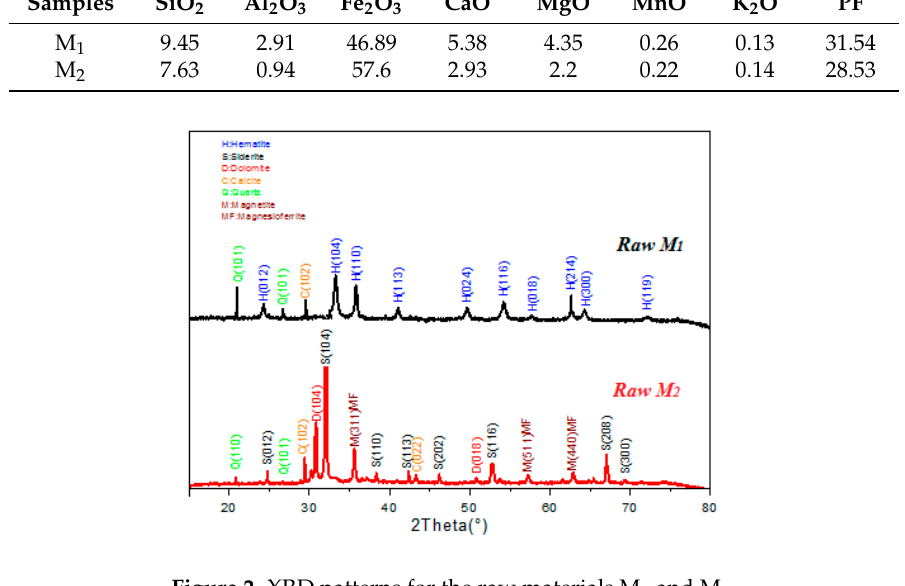
Figure 2. XRD patterns for the raw materials M 1 and M 2 . Table 2. Textural properties of the two raw